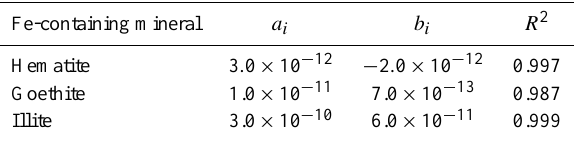
dividual Fe-containing